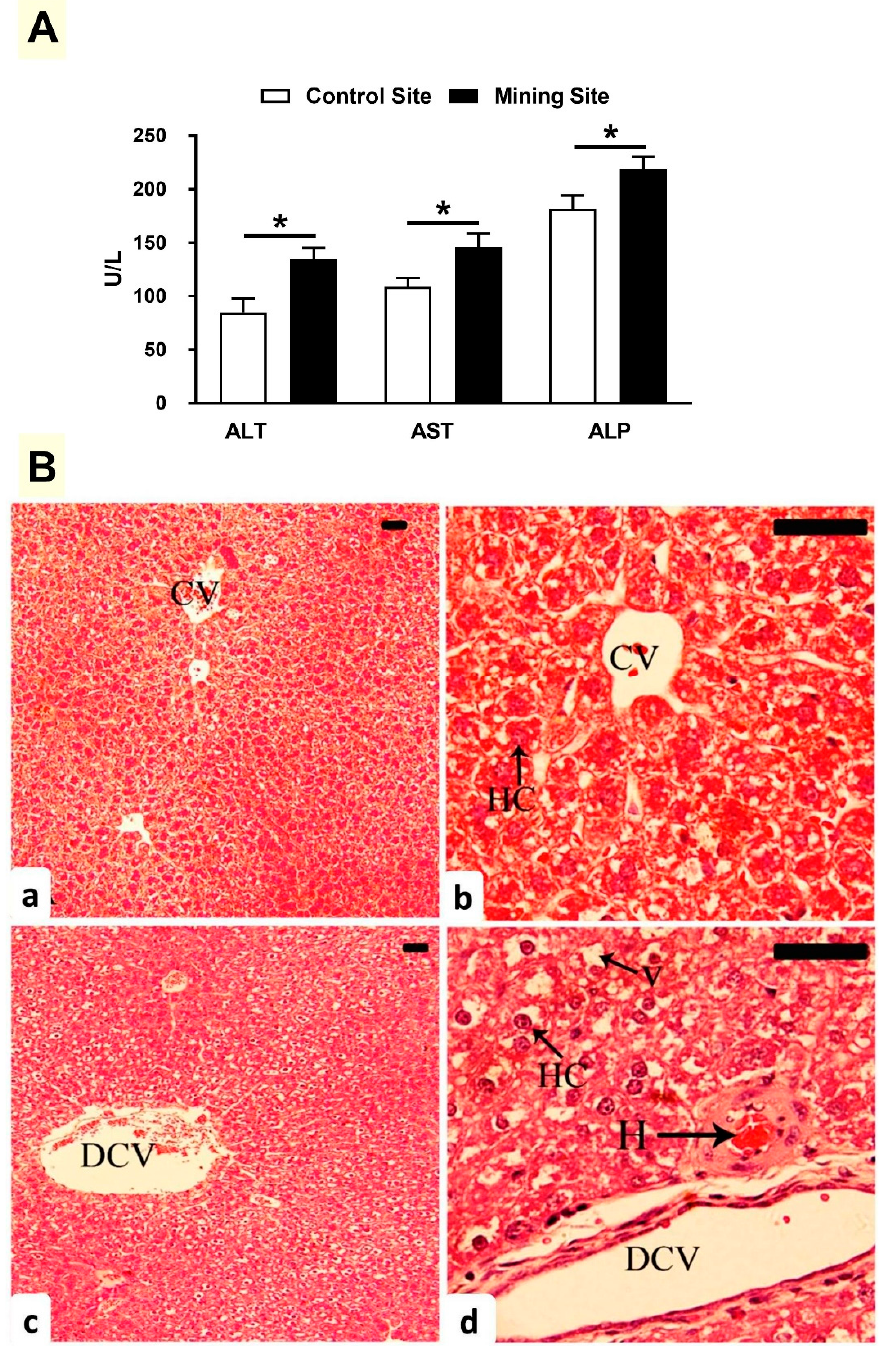
Figure 4. ( A ) Effect of mining activities on liver function markers of G. nanus . Data are means ± SEM, ( n = 8). * p < 0.05. ( B ) Photomicrographs of H&E-stained sections in the liver of G. nanus from the control site ( a , b ) showing normal structure of hepatocytes (HC) and central vein (CV); and animals from the mining site ( c , d ) showing a dilated central vein (DCV), hemorrhage (H), and vacuolations (V). Scale bar = 100 μ m.